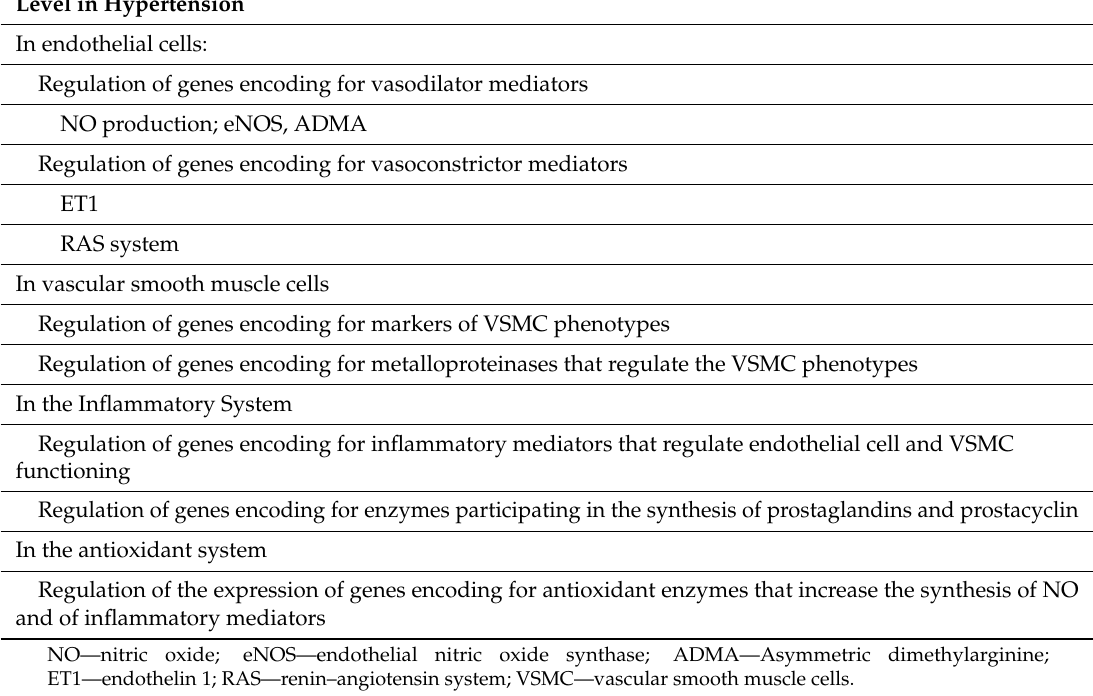
Table 1. Targets for epigenetic programming in essential arterial hypertension at the vascular